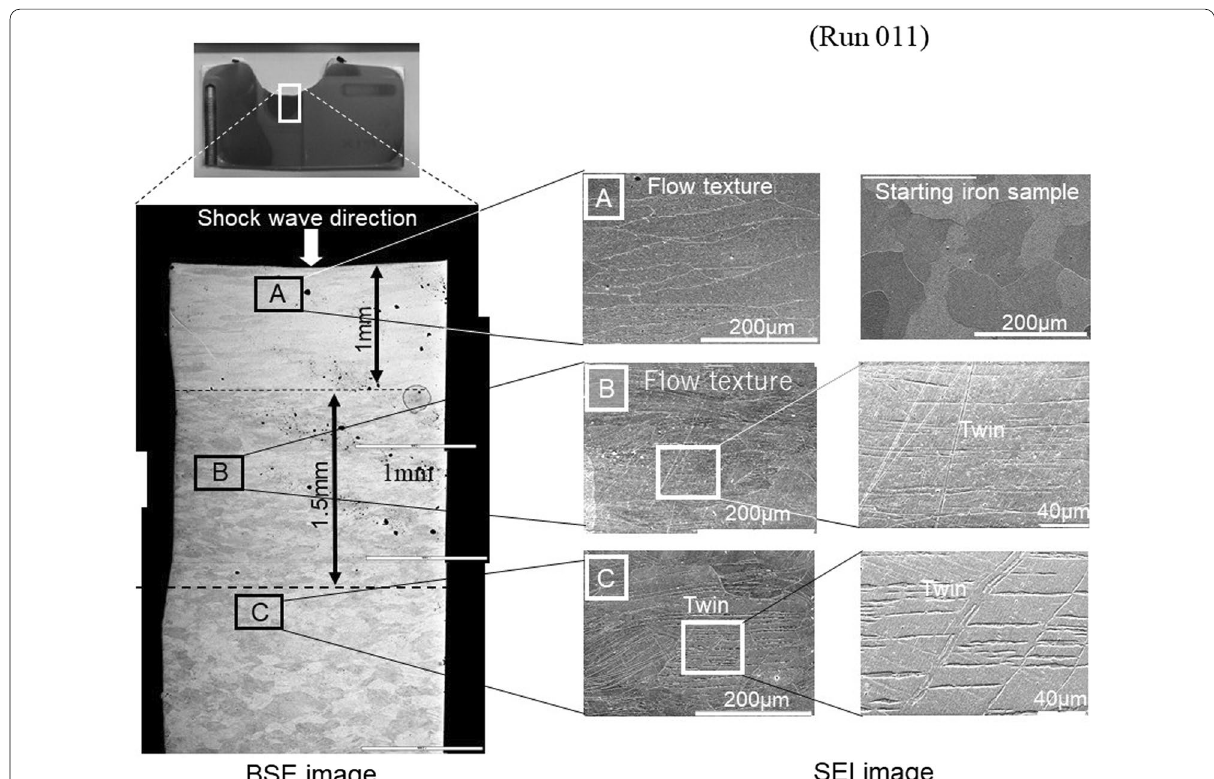
Fig. 5 The optical and backscattered electron (BSE) images of the texture of the polished section adjacent to the crater surface within 3-mm depths of the sample impacted at room temperature (Run 011). Its high magnification secondary electron images (SEI) are also shown